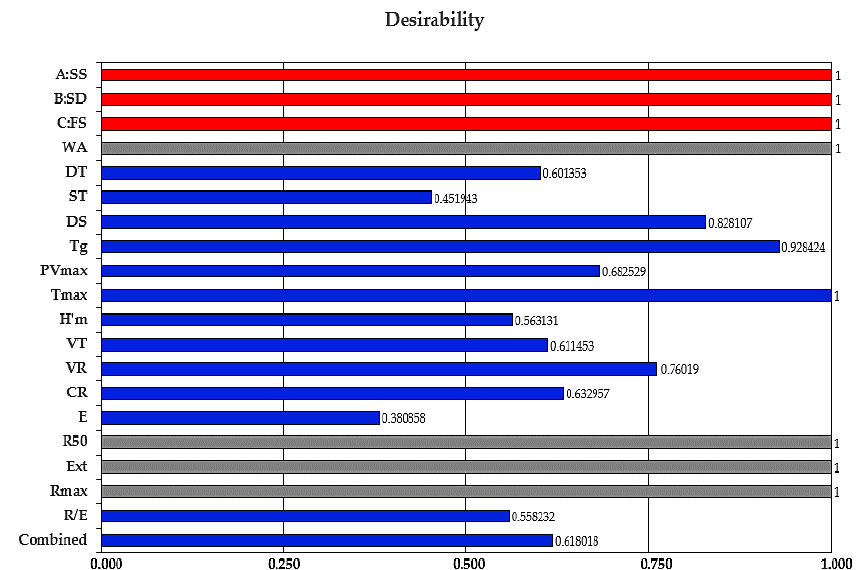
Figure 5. Desirability function scores for the studied independent and dependent variables: sea salt (SS), dry sourdough (SD), fermented sugar (FS), water absorption (WA), dough development time (DT), dough stability (ST), degree of softening at 10 min (DS), gelatinization temperature (T g ), peak viscosity (PV max ), temperature at peak viscosity (T max ), maximum height of gaseous production (H’m), total CO 2 volume production (VT), volume of the gas retained in the dough at the end of the test (VR), retention coe ffi cient (CR), energy (E), resistance to extension (R 50 ), extensibility (Ext), maximum resistance to extension (R max ) and ratio number (R / E) at a proving time of 135 min. Table 6. The characterization of wheat flour dough rheological properties with 1.5% NaCl